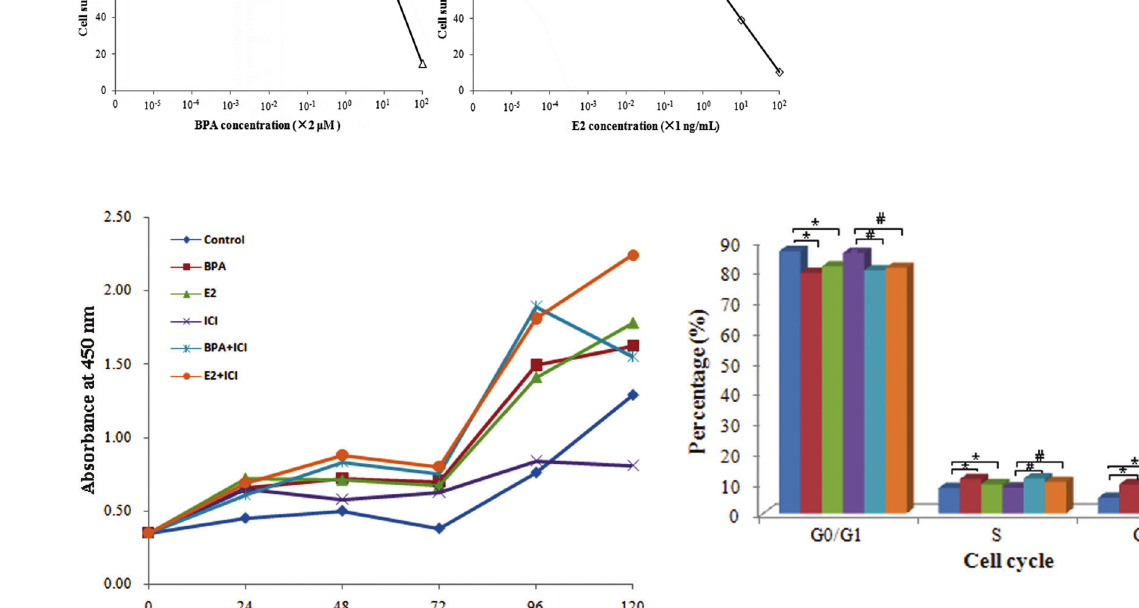
Figure 2. Inhibitory effect of bisphenol A (BPA) and estradiol (E2) on normal liver cell survival. The inhibitory action was stronger with increased dosage of BPA and E2.